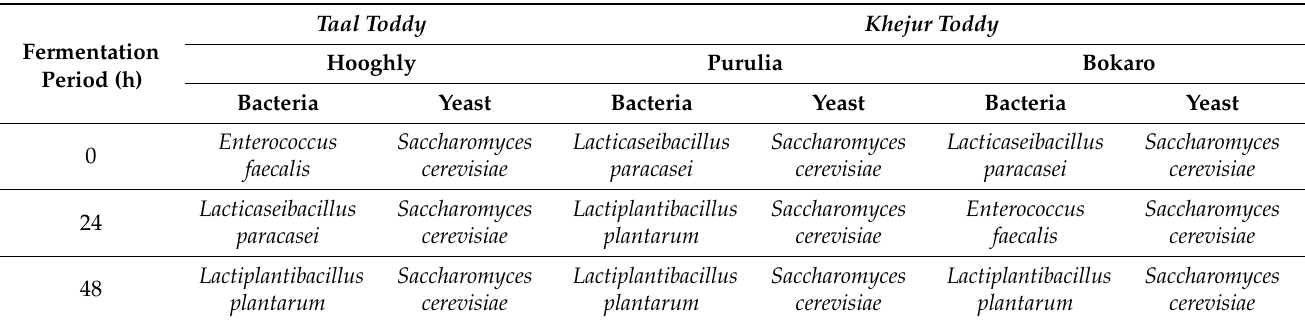
Table 1. Identification of microorganisms in fermenting palm saps during natural fermentation of toddy